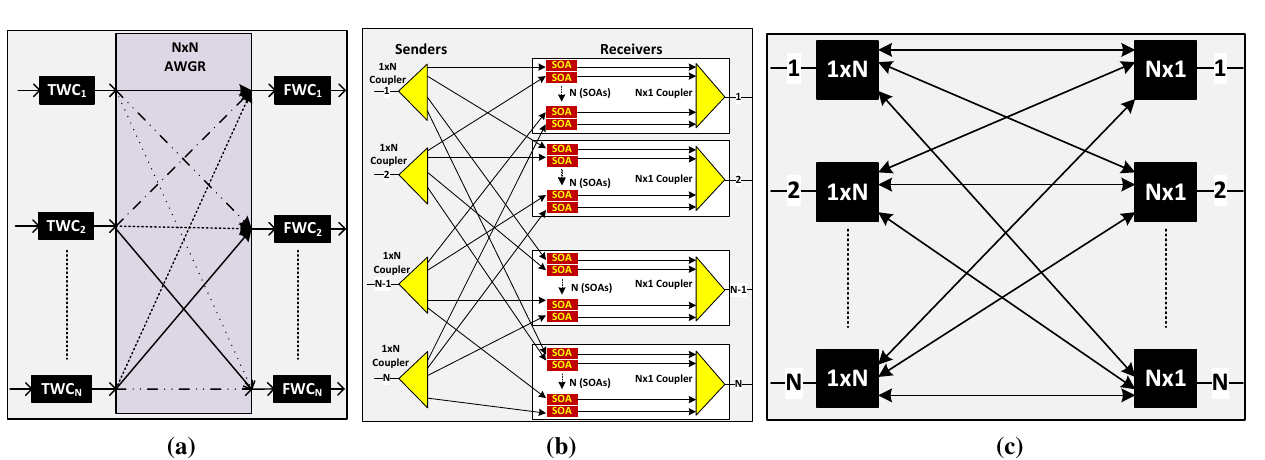
Figure 2. Different types of fast optical switches. ( a ) arrayed waveguide grating routers (AWGR) Switch; ( b ) emiconductor optical amplifier (SOA) Switch; ( c ) 1 × N Photonic